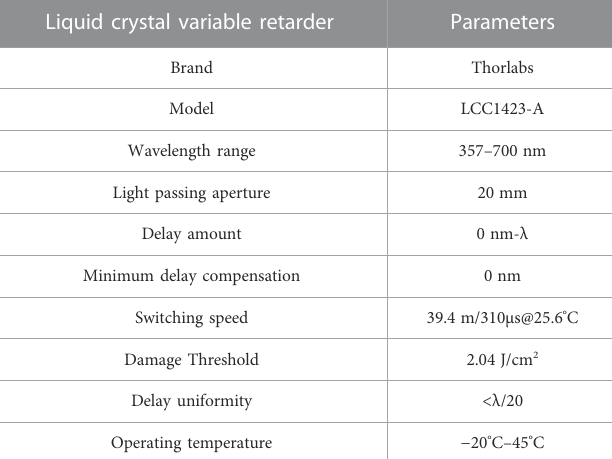
TABLE 2 Liquid crystal tunable fi lter parameters. Liquid crystal tunable fi lter